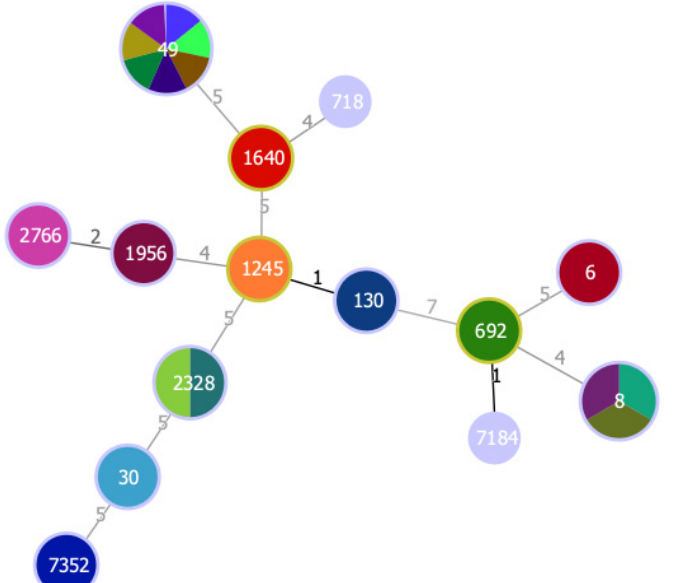
Figure 1. Minimum spanning tree, based on MLST of 23 S. aureus isolated from wild owls. The minimum spanning tree graph (MST) was created with PHYLOViZ using the goeBURST algorithm [71]. The dominant STs are represented by the circles with larger diameters. Each color represents one isolate. Numbers on lines indicate locus variants between adjacent nodes.